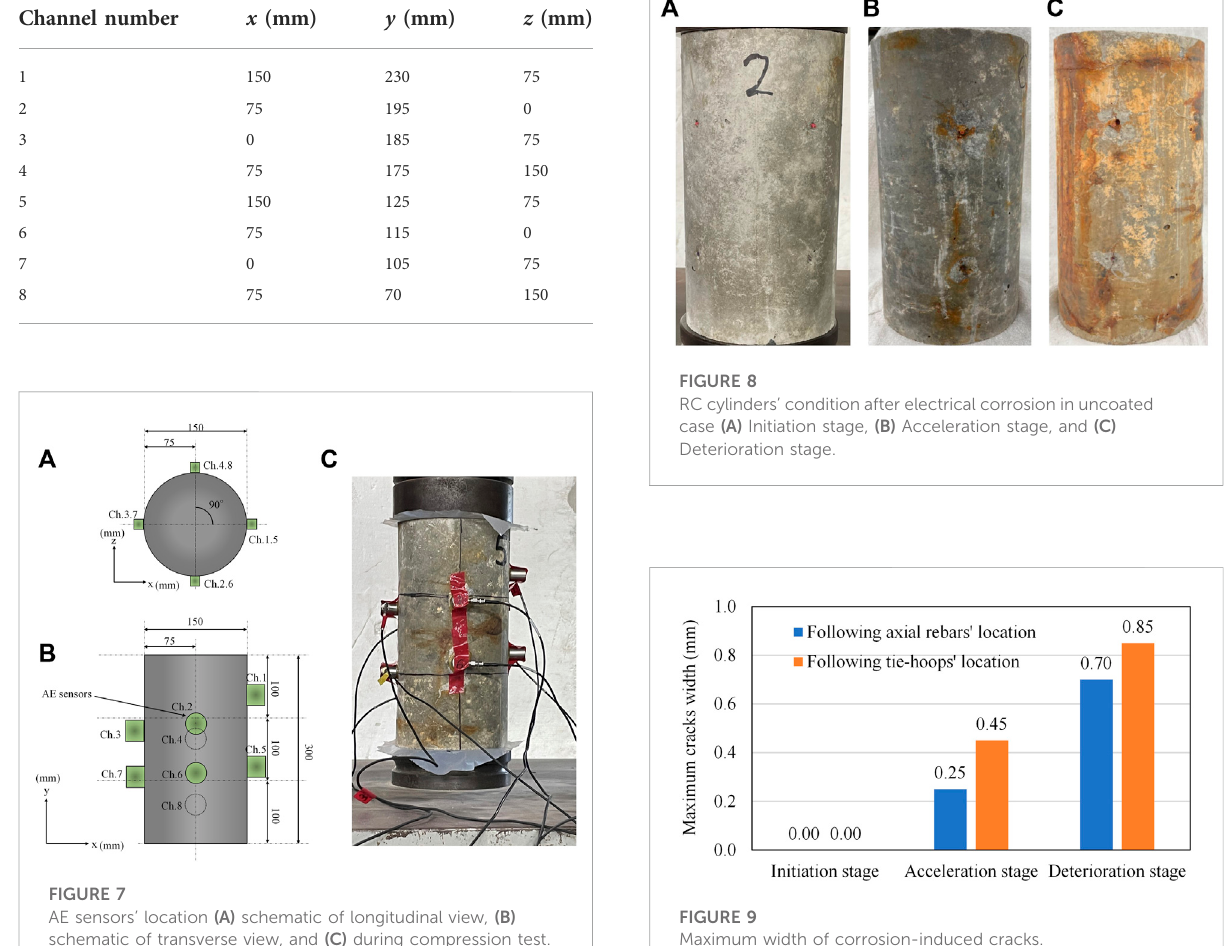
FIGURE 9 Maximum width of corrosion-induced